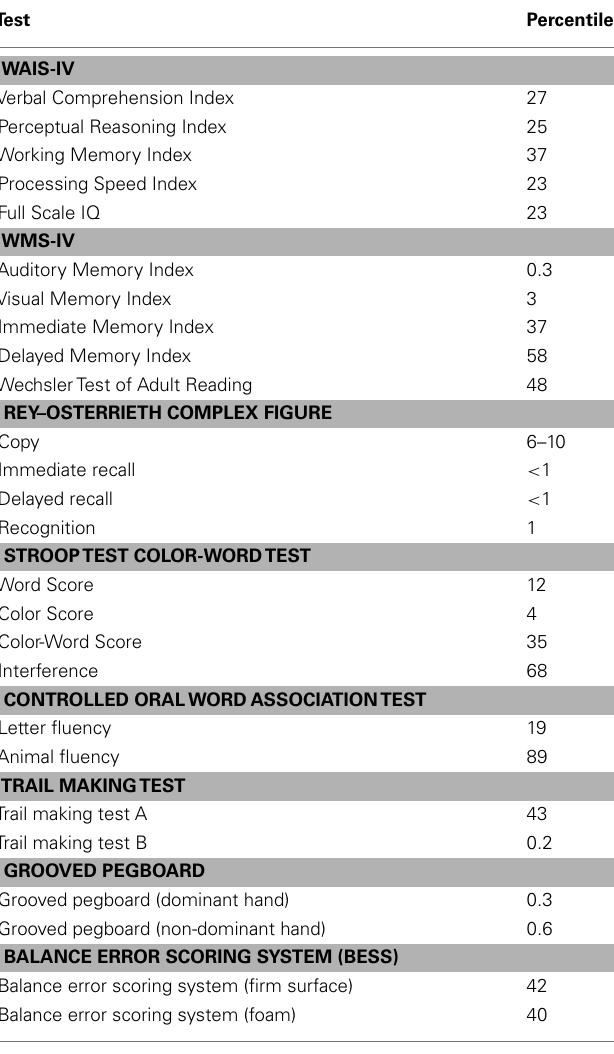
Table 2 | Neuropsychological assessment